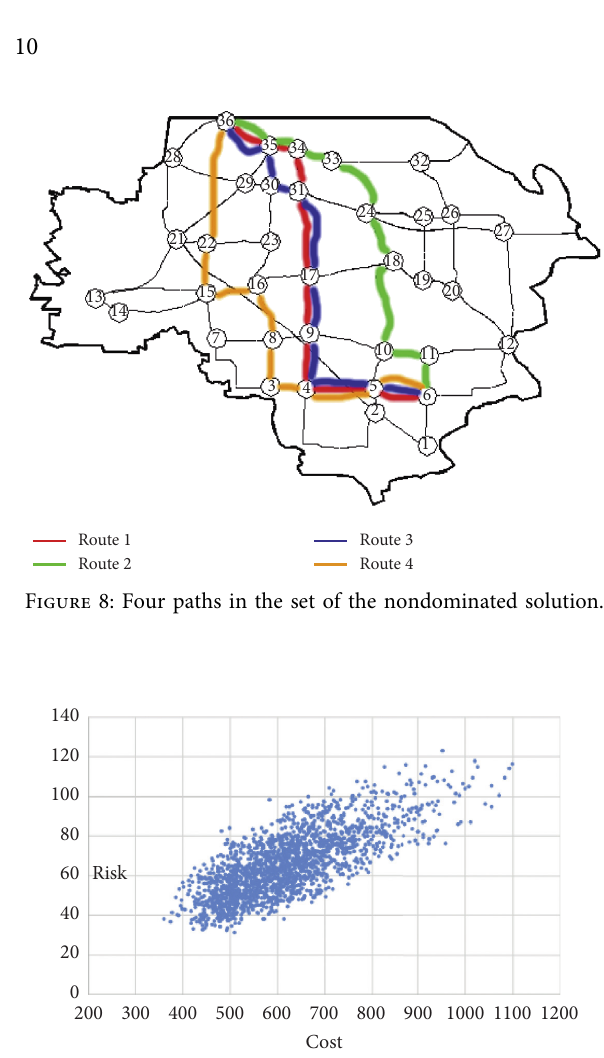
Figure 9: Scatter diagram of feasible solutions from Depth-First Search (7:00).